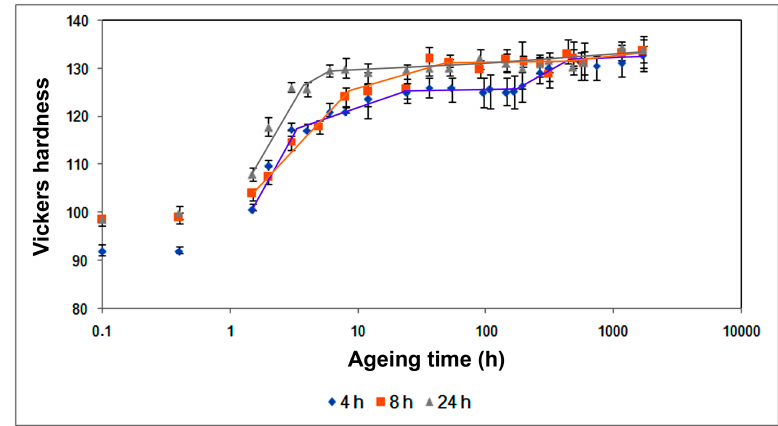
Figure 9. Hardness profiles after a solution treatment at 495 °C for 4, 8, and 24 h and subsequent natural ageing (21 °C) for up to 1700 h. Error bars define the distance between the maximum and minimum values vs. the average value.